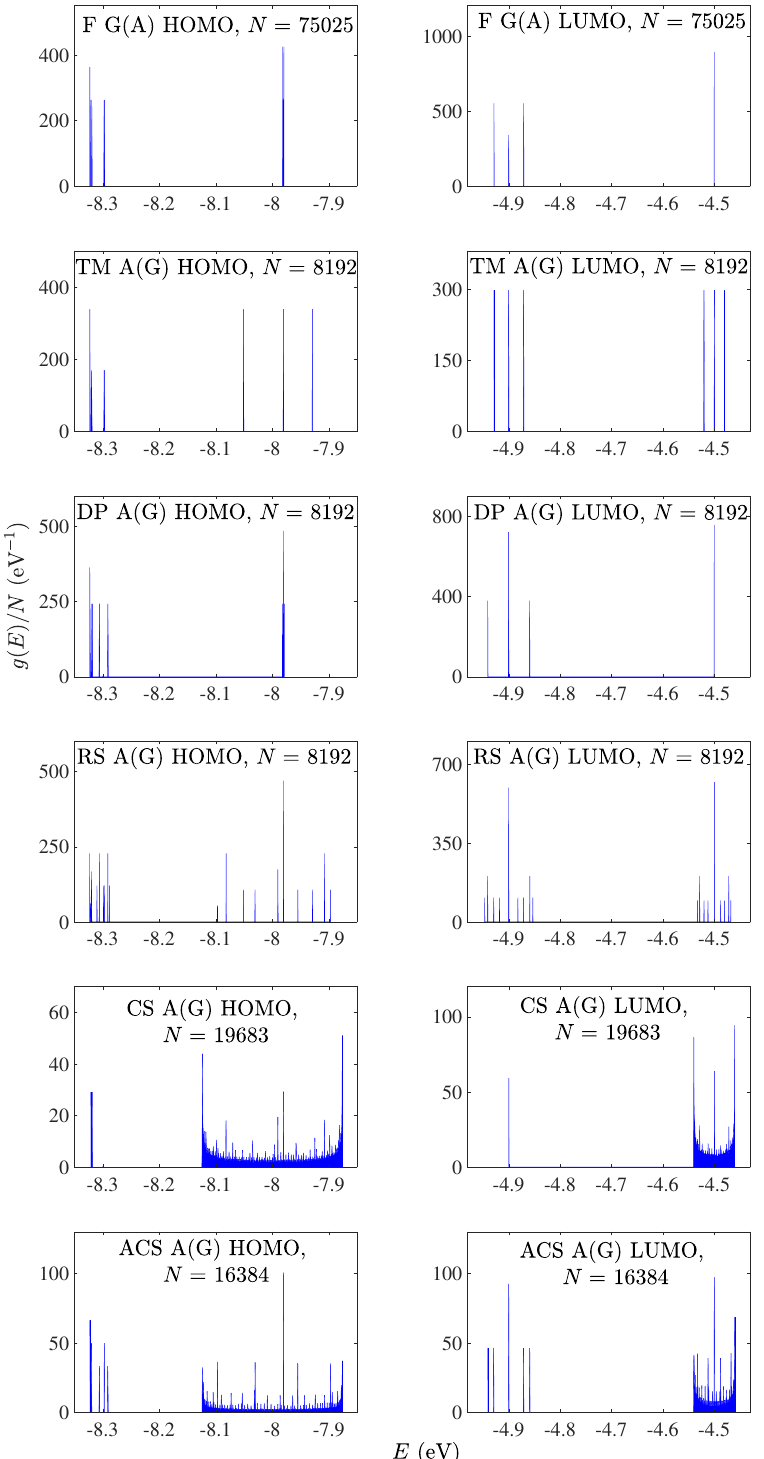
Figure 4. Density of states of F G(A), TM A(G), DP A(G), RS A(G), CS A(G), ACS A(G) polymers, for the HOMO (left column) regime and the LUMO (right column) regime, for a generation with large N . The notation of polymers is given in Table